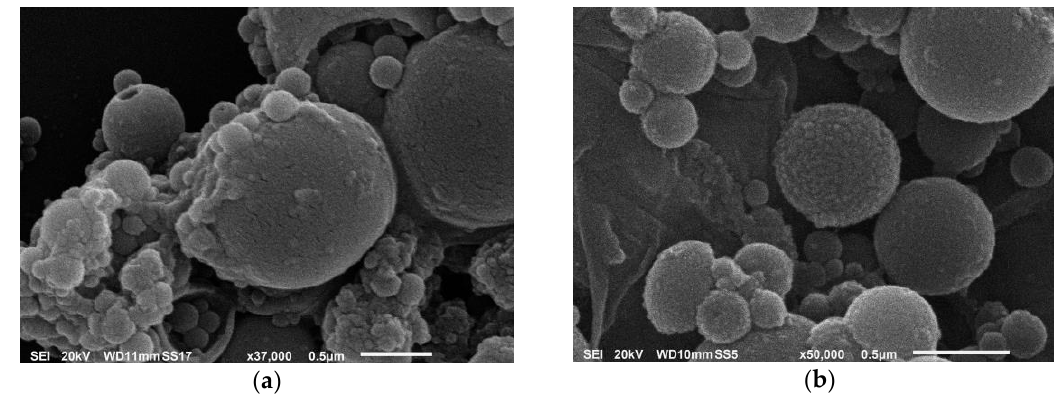
Figure 5. SEM images of catalyst III in the first panel ( a ) and of catalyst IV in the second panel ( b ).